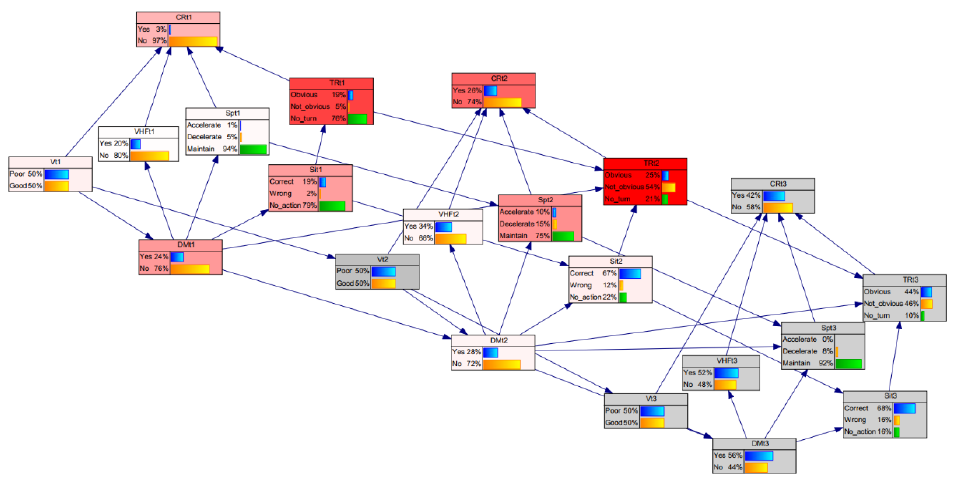
Figure 10. Node influence degree under the medium collision risk (CRt 2 ) in the DBN model.